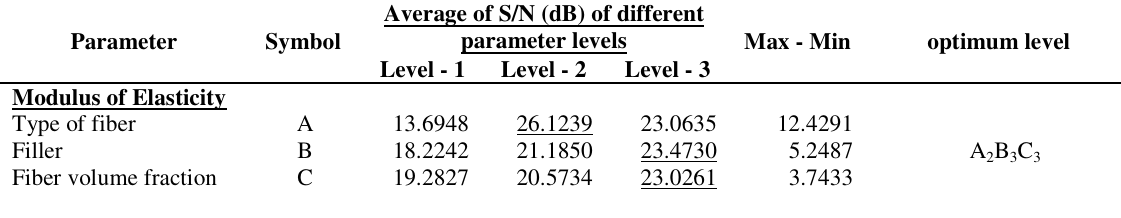
Average signal to noise ratio of different parameter levels.